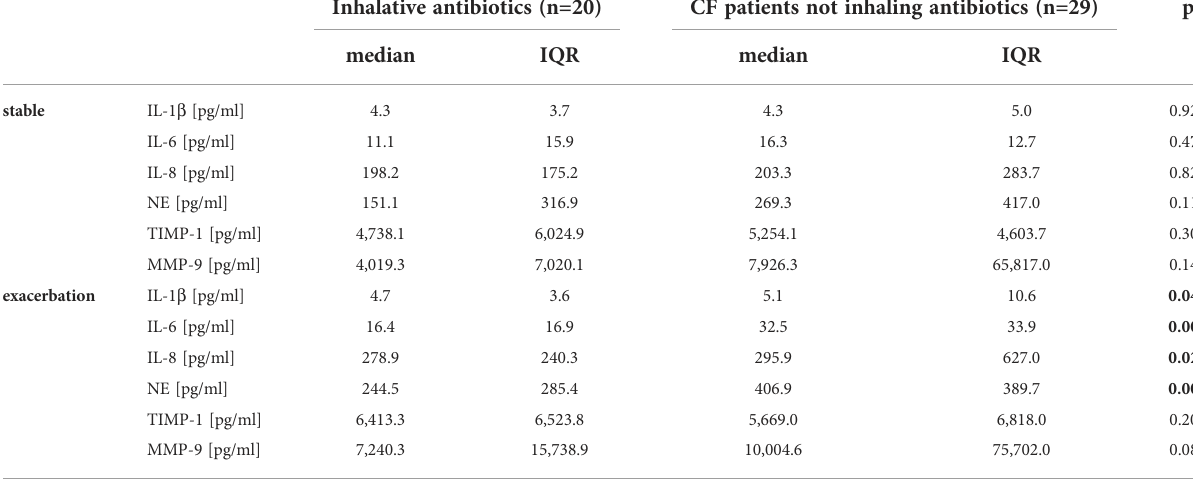
TABLE 2 In fl ammation markers during stable phase and exacerbation in CF patients in relation to inhalative antibiotics (colistin, tobramycin, or aztreonam). Inhalative antibiotics (n=20) CF patients not inhaling antibiotics